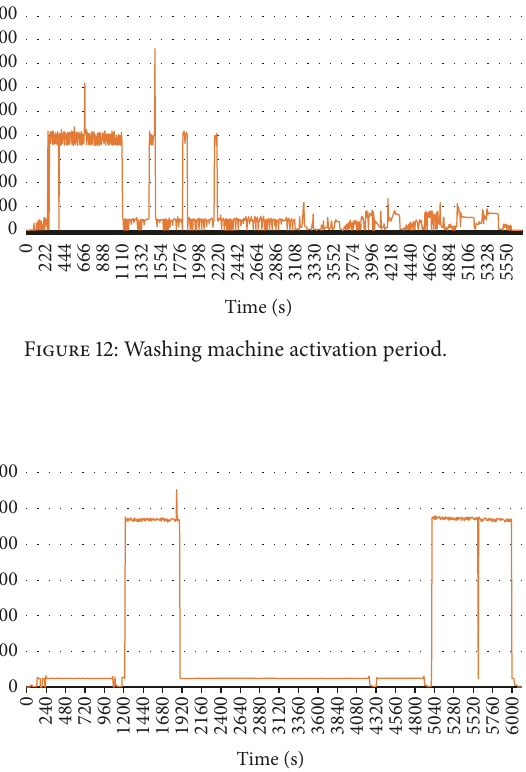
Figure 15: Kettle activation period.